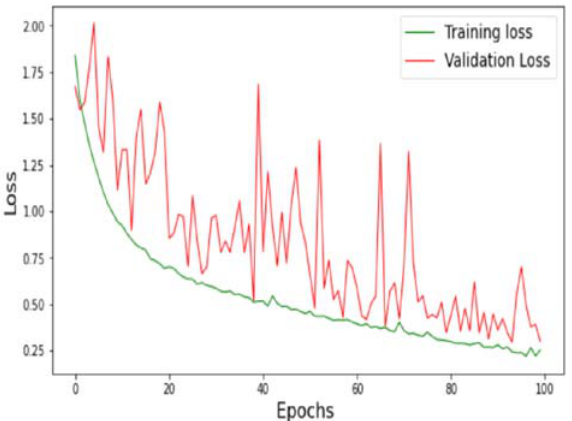
Figure 7. Confusion